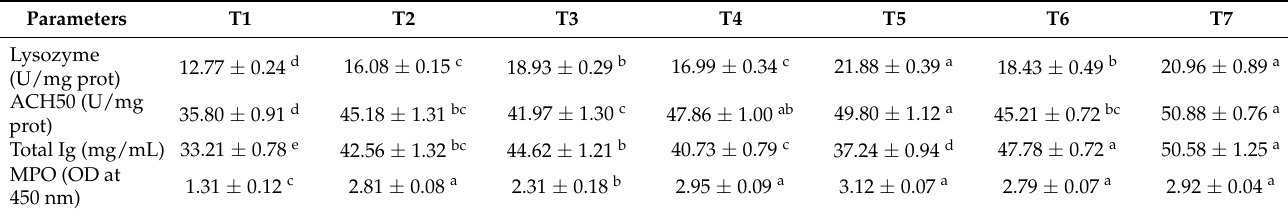
Table 2. Intestine immune parameters of zebrafish fed on diets with different levels of synbiotic Biomin ® IMBO and/or Persian shallot for 60 days. T1, control (without any supplementation); T2, 1% synbiotic; T3, 3% synbiotic; T4, 1% Persian shallot; T5, 3% Persian shallot; T6, 1% Persian shallot and 1% synbiotic; T7, 3% Persian shallot and 3%